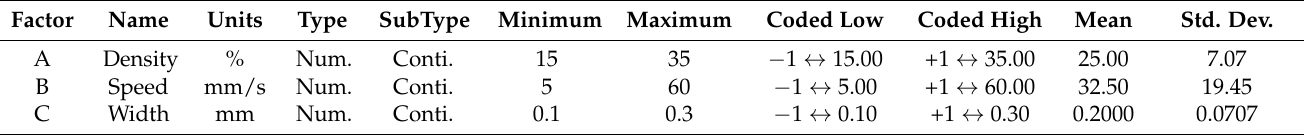
Table 2. Input Parameters of the DoE.